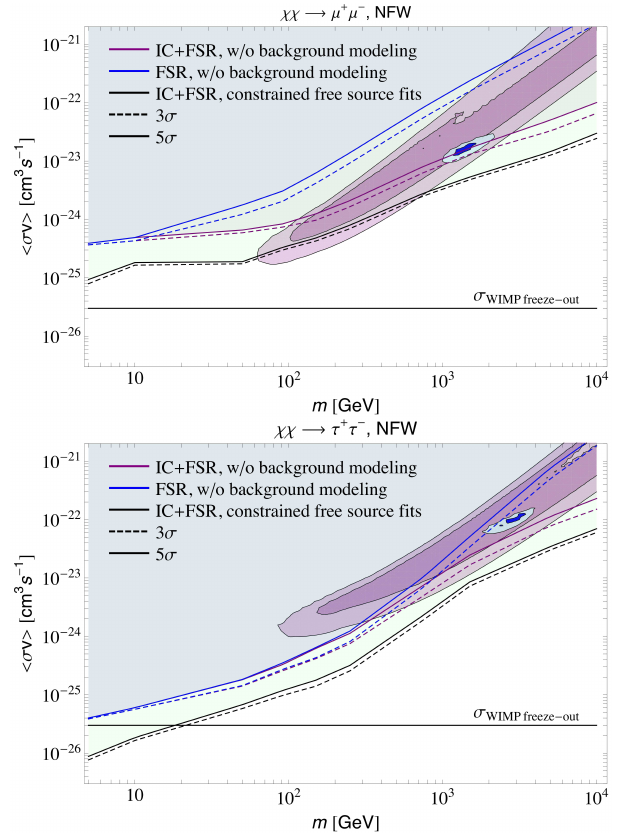
Figure 1: Derived 95% C.L. upper limits on WIMP an- nihilation cross sections in the Milky Way halo, for the muon ( left ) and tau ( right ) annihilation channels. The purple and blue contours show PAMELA and Fermi positron excess DM interpretation constraint